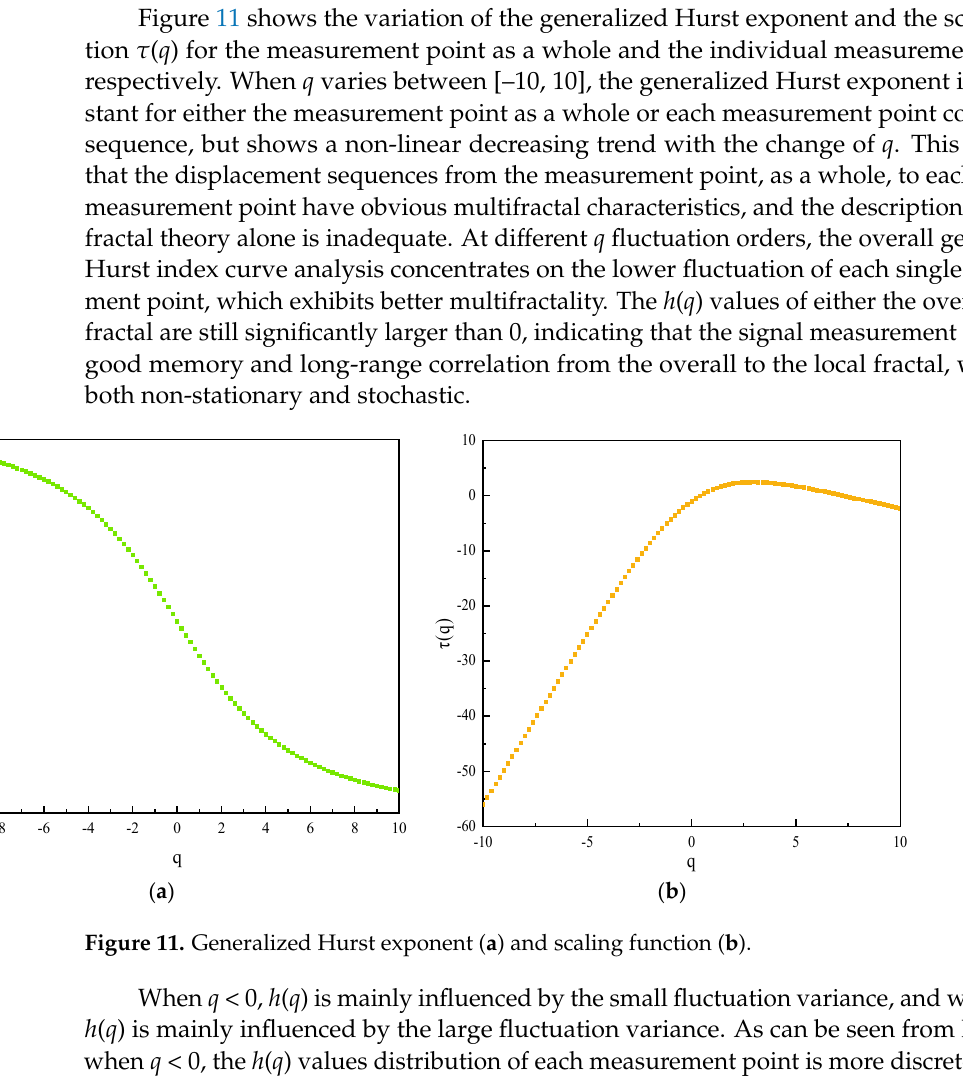
Figure 12. Multifractal spectrum of typical acoustic emission signals.